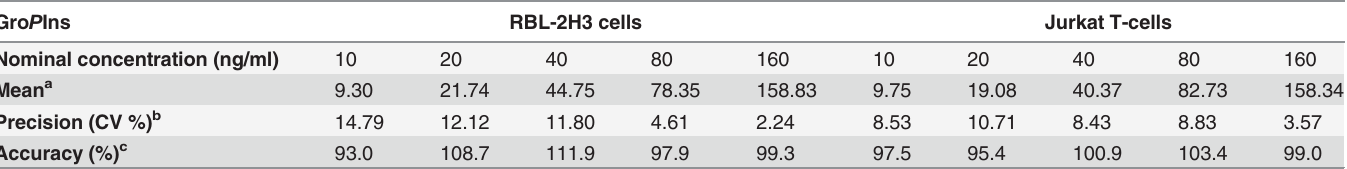
Table 5. Inter-day precision and accuracy in RBL-2H3 and Jurkat T-cell extracts. Gro P Ins RBL-2H3 cells Jurkat T-cells Nominal concentration (ng/ml) 10 Mean a Precision (CV %) b Accuracy (%) c 93.0